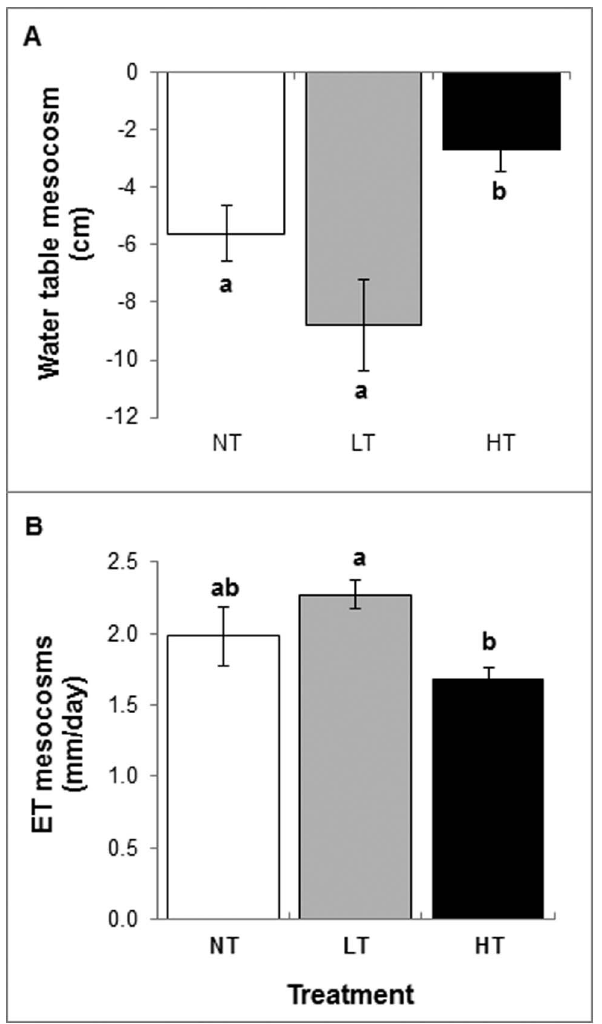
Figure 1. Effects of tree density on water table (panel A) and mesocosm evapotranspiration (panel B). Bars represent means + 1 SE (n=5) per birch density treatment. NT=control without trees, LT=low tree density, HT=high tree density. Mesocosm evapotranspi- ration was averaged over the first summer (period V, calendar week 19– 32, 2008). Water table values refer to the situation at the end of period V, as measured at the beginning of week 33. Water table level was measured relative to a fixed point (the overflow outlet), which was 10– 15 cm below the moss surface. Different letters above the bars denote statistically significant ( P , 0.05) differences between tree density treatments based on 2-way ANOVAs with treatment as factor and block as random